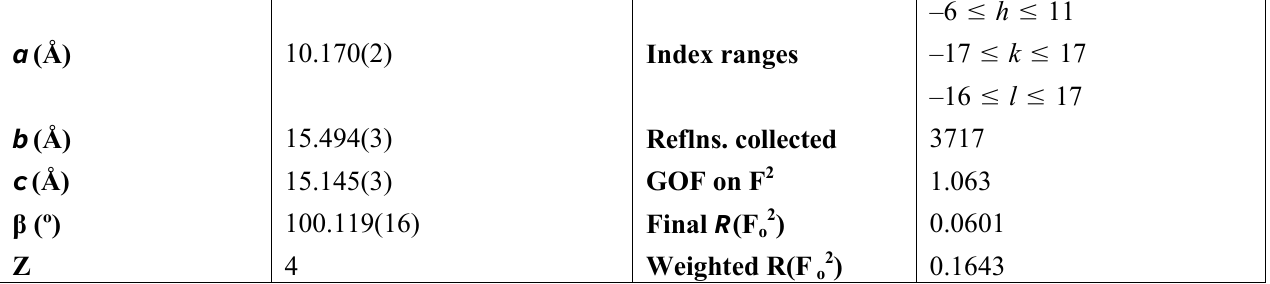
Table 2. Selected Bond Lengths (Å) and Angles (º) for [Ni(ppe-py)(H